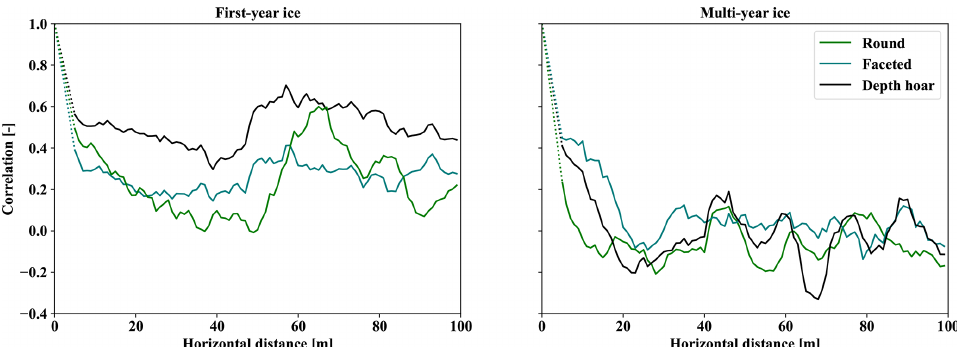
Figure 10. Spatial auto-correlation of snowpack fractional composition by layer type on FYI and MYI as estimated from classified SMP profiles. Dotted lines show assumed correlation at length scales less than 1m where geolocation uncertainty of the profiles precludes